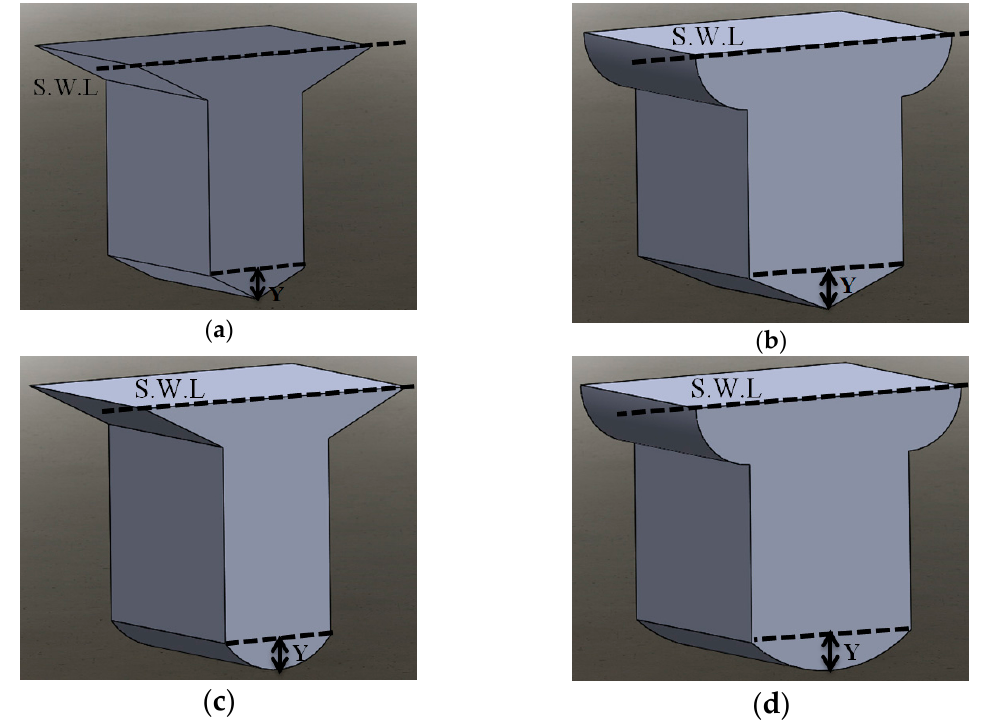
Figure 24. Description of the ( a ) upside chamfered-bottom chamfered shape, ( b ) upside filleted-bottom chamfered shape, ( c ) upside chamfered-bottom filleted shape, and ( d ) upside filleted-bottom filleted shape.